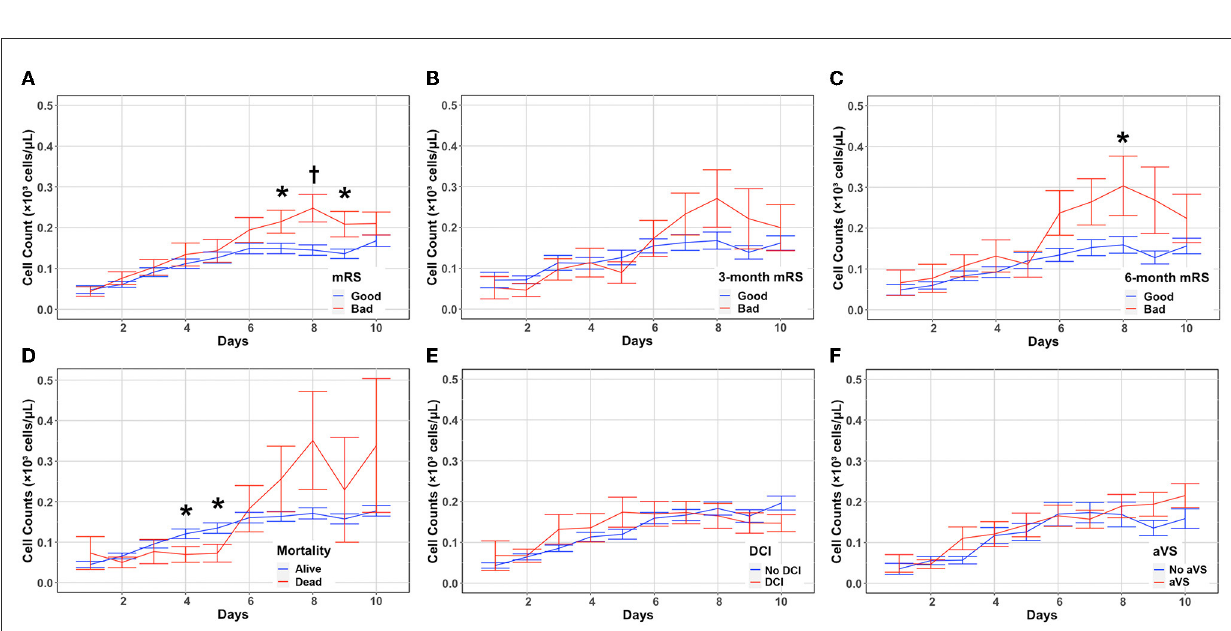
FIGURE2 Absolute eosinophil count changes and associations with SAH outcomes. Eosinophil counts (mean and standard deviation) are shown from the day of aneurysmal rupture (Day 0) through day 10. Cells are in units of 1,000 per mm 3 . Counts were stratified by discharge mRS (A) , 3-month mRS (B) , 6-month mRS (C) , in-hospital mortality (D) , DCI (E) , and aVS (F) . * P < 0.05, † P < 0.001. aVS, angiographic vasospasm; DCI, delayed cerebral ischemia; mRS, modified Rankin Scale.